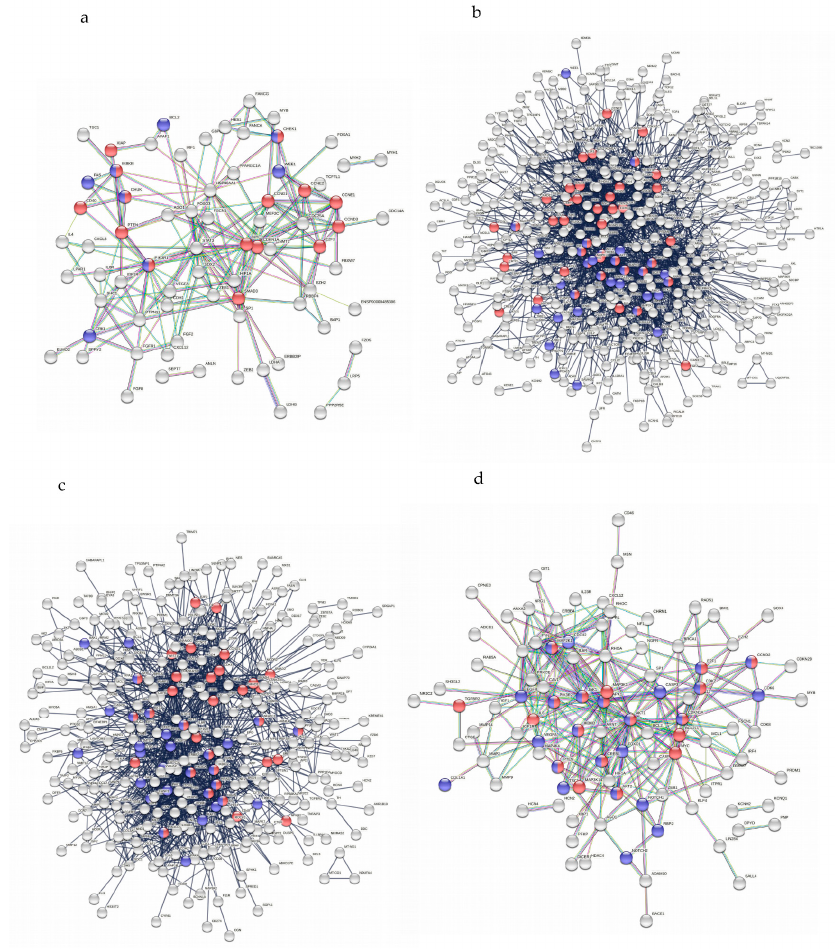
Figure 5. Analysis of PPIs of the target genes of miRNAs down regulated and upregulated in infected PBMCs (( a , b ) respectively) and BJABGu cells (( c , d ) respectively) related to HIV-1 and HTLV-1 anno- tations. Red nodes are associated with HTLV-1 infection, while blue nodes are associated with HIV-1 infection. Double coloured nodes share both annotations (genes name are listed in Supplementary S2).